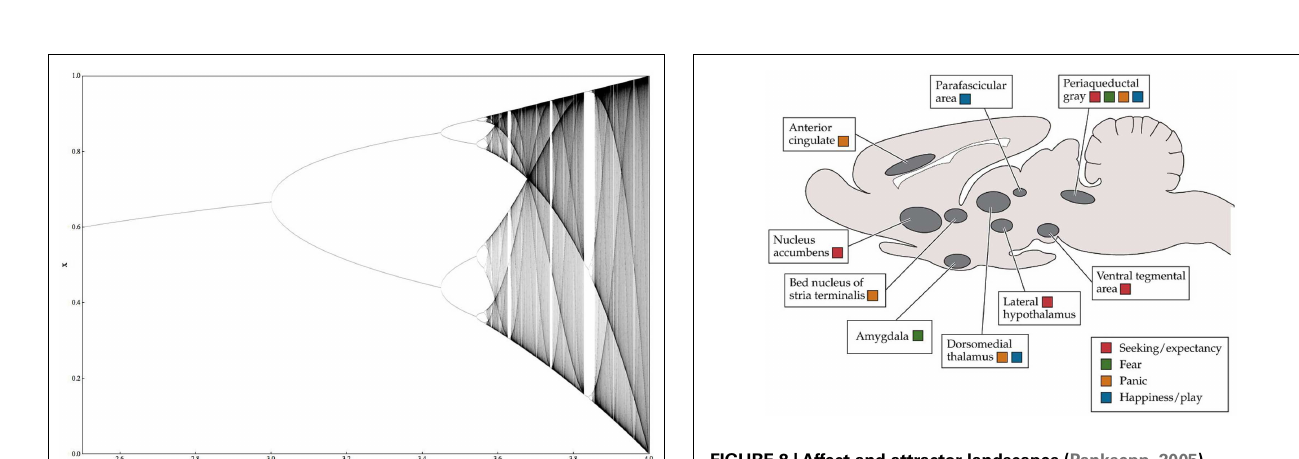
FIGURE 8 |Affect and attractor landscapes (Panksepp,